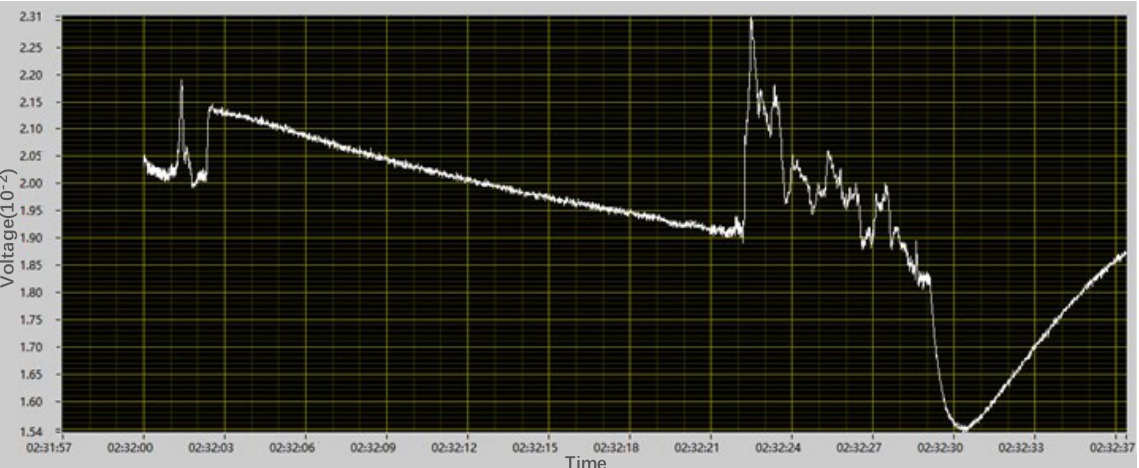
Figure 13. Output voltage.